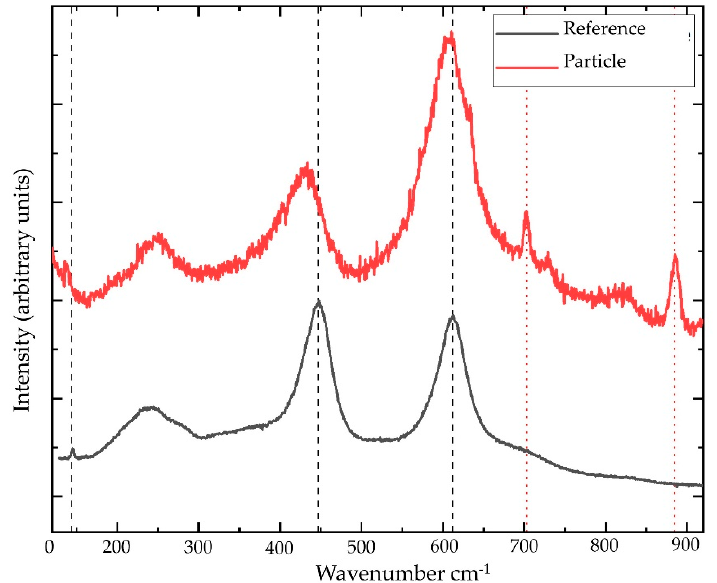
Figure 2. Raman spectrum of a needle (red) compared to a reference spectrum of rutile (black) from the free database Handbook of Raman spectra Lyon University (http://www.geologielyon.fr/Raman/spectrum accessed on 6 April 2021). Black dashed lines are eye-guides for the wavenumbers of the three Raman active modes in rutile (near 146, 447 and 612 cm − 1 ). Red dotted lines indicate two of the main Raman peaks visible from the surrounding polycarbonate (near 702 and 884 cm − 1 ).